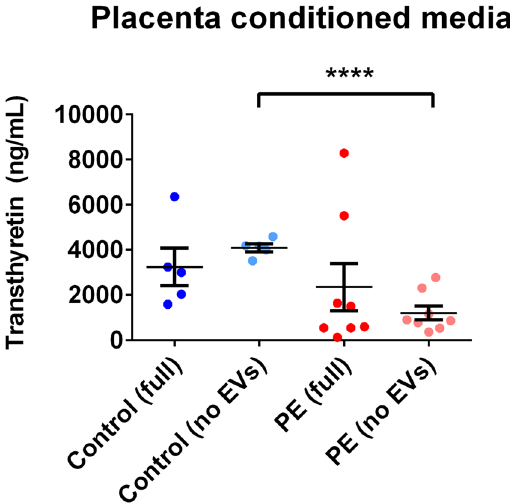
Figure 5. Transthyretin levels in vesicle-depleted and vesicle-replete conditioned media from preeclamptic and normotensive placentae. The concentrations of transthyretin in the conditioned media from normotensive control and preeclamptic placentae were measured by sandwich ELISA. For each sample, extracellular vesicles were depleted from half of the conditioned media by centrifugation at 100,000 g for one hour, and the vesicle- depleted (no EVs) and vesicle-replete (full) conditioned media were assayed together ( **** p < 0.0001). Mean and SEM are